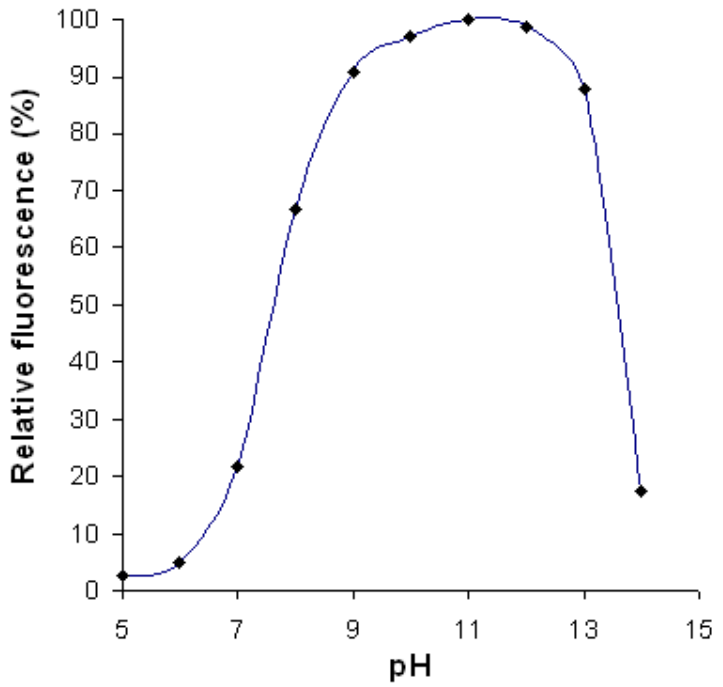
Figure 4. pH effects on GSH-MBB adduct formation. A 20 µ M GSH solution was incubated for 7.5 min with MBB and reaction buffer at the indicated pH. Relative fluorescence was set at 100 for pH 11.